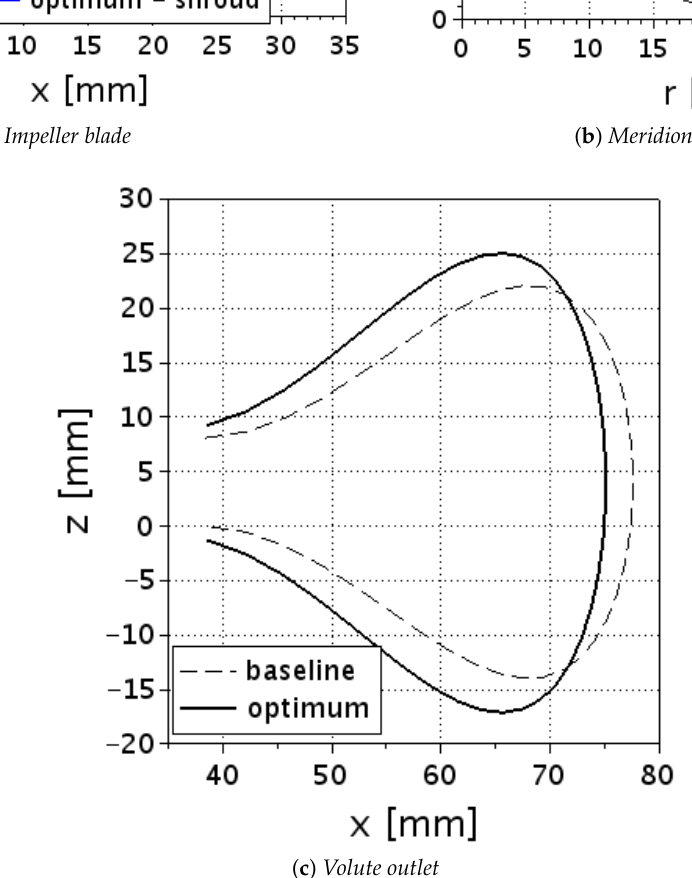
Figure 15. Comparison between baseline and optimized